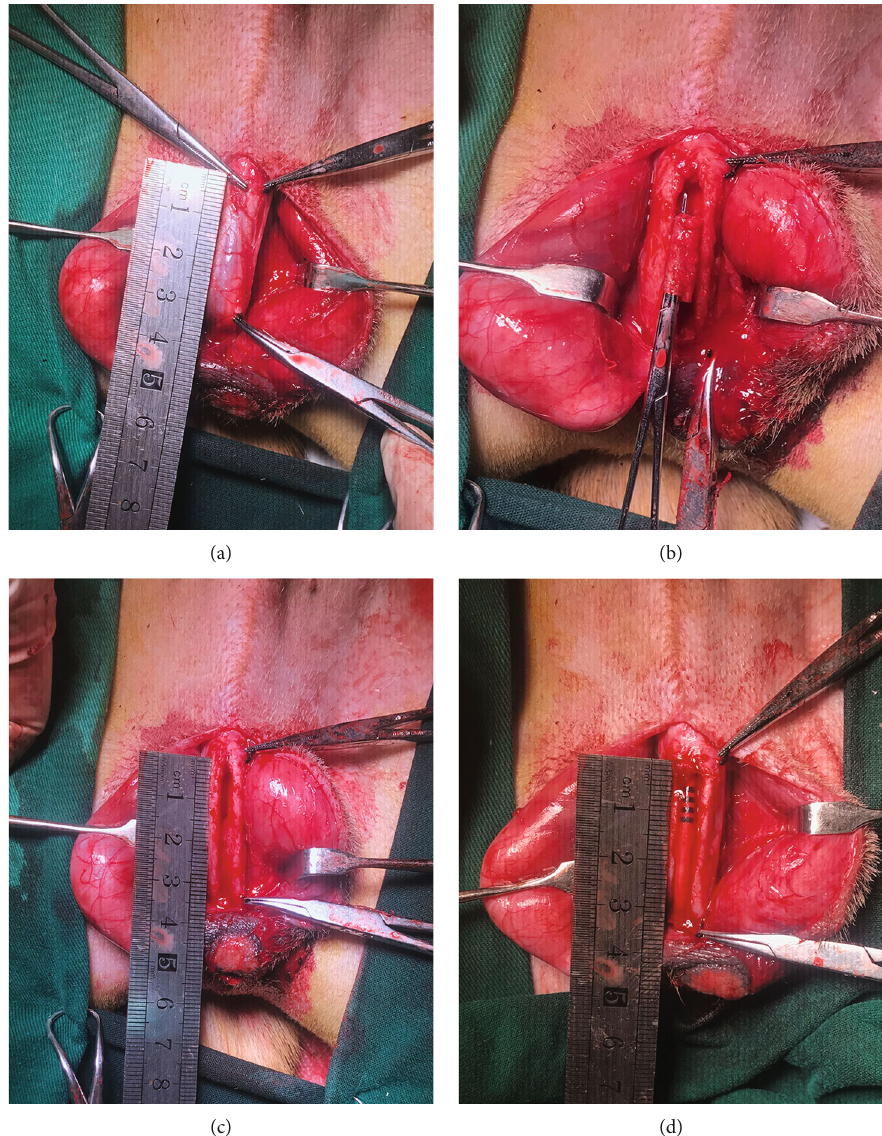
Figure 1: Surgical procedures of urethroplasty. A 3 cm long segment of the urethra (about 17% of the entire length of the urethra) starting distal to the bulbous urethra was transected and removed (a – c). The cell-seeded acellular arterial matrix was used to substitute the urethral defect